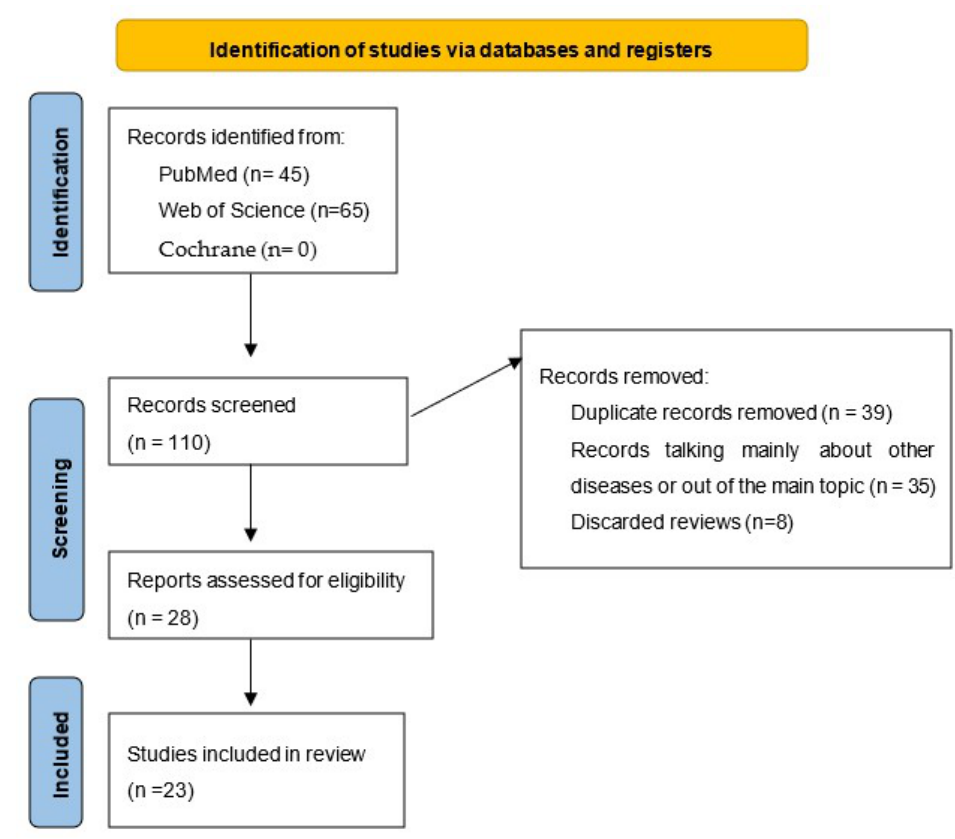
Figure 3. PRISMA 2020 Flow chart. This figure synthetizes the several phases of this systematic review. The data were collected from August to September 2022 and reviewed in September and October.